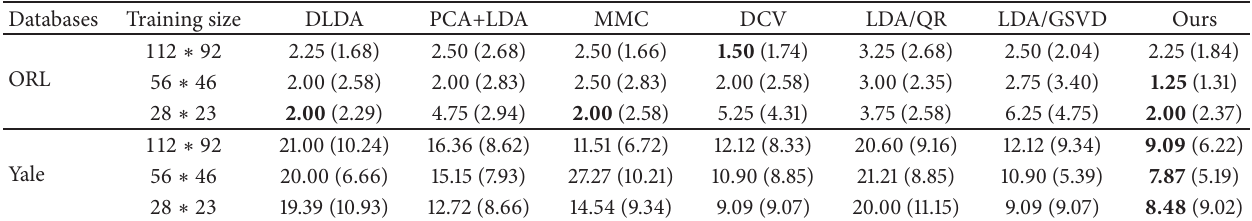
Table 3: Comparisons of misclassification rates (%) of several methods on face databases.